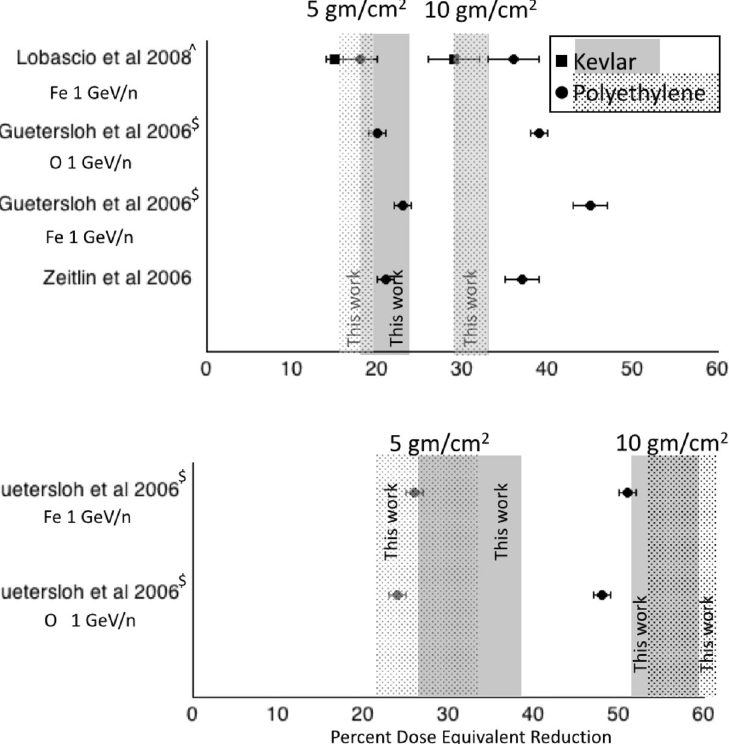
Figure 6. Comparison of our results (grey areas, thickness indicating ±σ ) with other published results. Full gray area: our Kevlar results; patterned gray area: our Polyethylene results. Squared symbols: ground Kevlar results; round circles: ground Polyethylene results. Errors correspond to standard deviations ( σ ). Our two results for the dose at 10 g/cm 2 are identical for the two materials. $ Extrapolated from values at 2.83 g/cm 2 , assuming linear relationship. In the paper other projectile species are considered. ^ Extrapolated from values for unit areal density, assuming linear